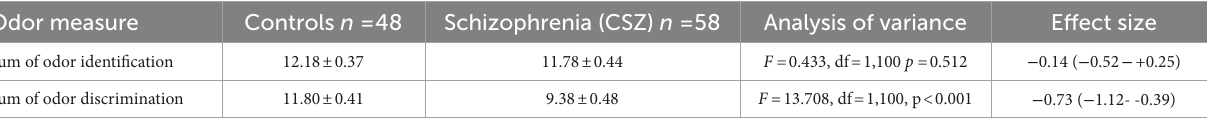
TABLE 3 Differences in odor identification and discrimination between controls and patients with Chronic Schizophrenia